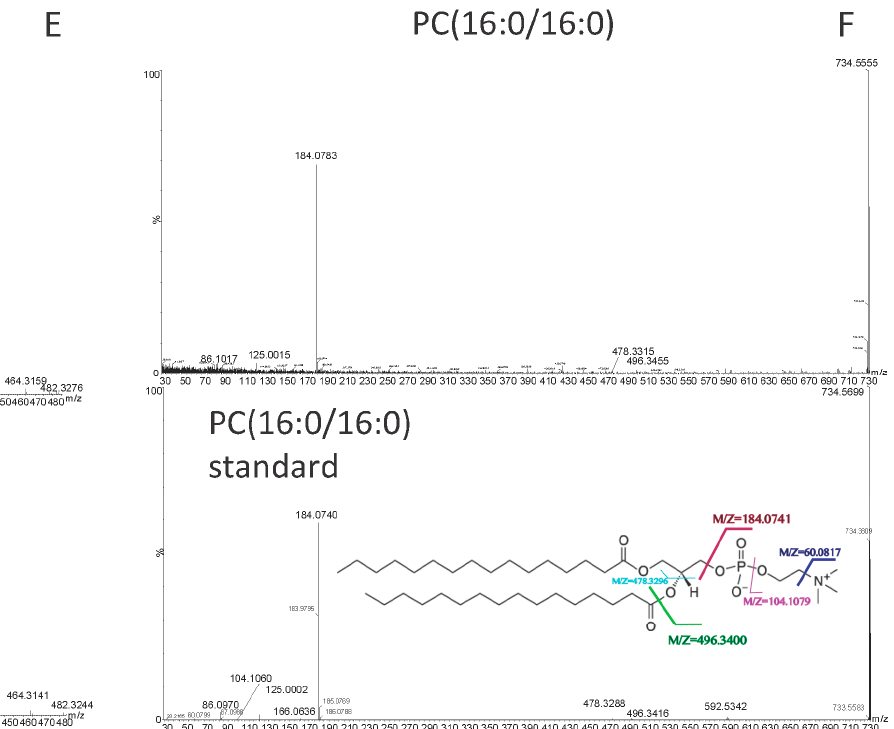
Figure 3. Cont. Figure 3.